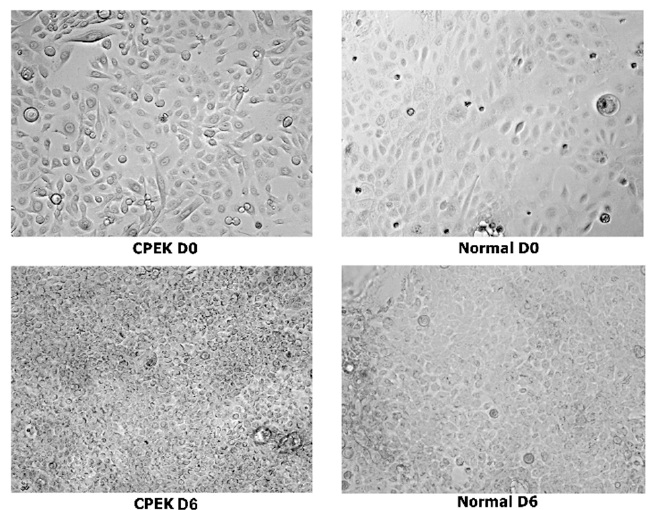
Figure 3. Composite showing unstained canine progenitor epidermal keratinocyte (CPEK) cells versus keratinocytes harvested from biopsies of normal dog at day 0 and day 6 of culture. CPEKs appear smaller and more numerous as time is progressing compared to NK. Images were taken at 40x.